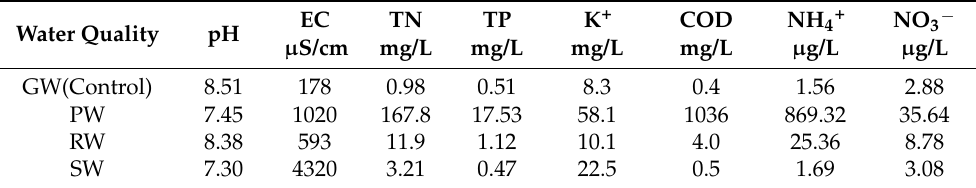
Table 2. The quality of four water source in